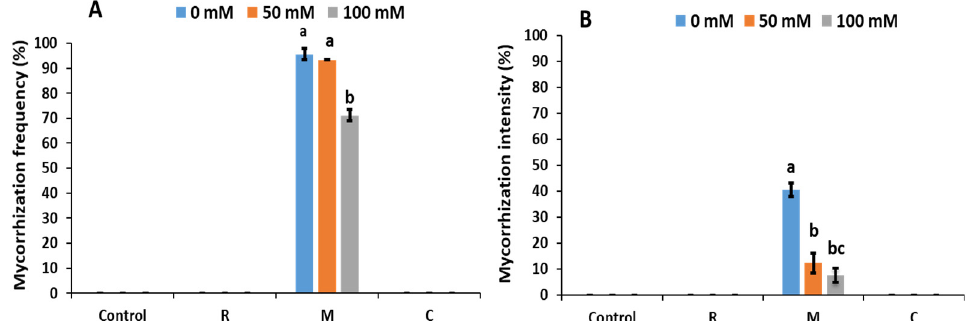
Figure 1. Influence of salinity levels (0, 50, and 100 mM NaCl) on ( A ) mycorrhization frequency and ( B ) intensity in lettuce control plants (non-amended, non-inoculated), and plants inoculated with plant growth promoting rhizobacteria (R), or arbuscular mycorrhizal fungi (M), or amended with composts (C). Data are mean ± SE of 10 biological replicates. Means followed by the same letters are not significantly different at p < 0.05 (Tukey’s HSD).